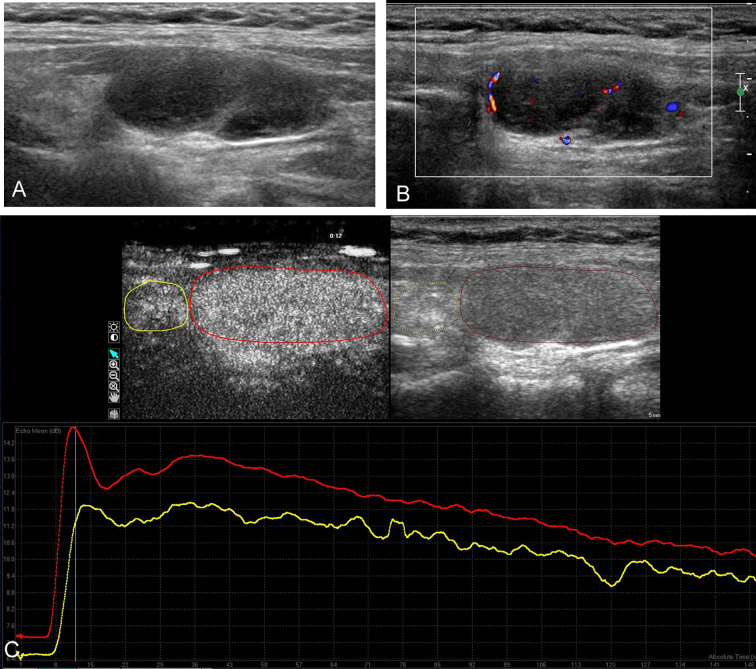
Conventional ultrasound and contrast-enhanced ultrasound images of the nodular Hashimoto’s thyroiditis in the left thyroid lobe of a 26-year-old female with diffuse Hashimoto’s thyroiditis background. (A) B-mode ultrasound image of a maximum diameter of 33 mm nodule displayed hypoechogenicity with well-defined margin. (B) Color Doppler image revealing the mainly peripheral distributed vascularity of the nodule. (C) Contrast-enhanced ultrasound image revealing the homogeneous hyper-enhancement of the lesion (red circle), with respect to the surrounding parenchyma (yellow circle); time–intensity curves of the lesion (red curve) and parenchyma (yellow curve) were generated to calculate the corresponding quantitative parameters.